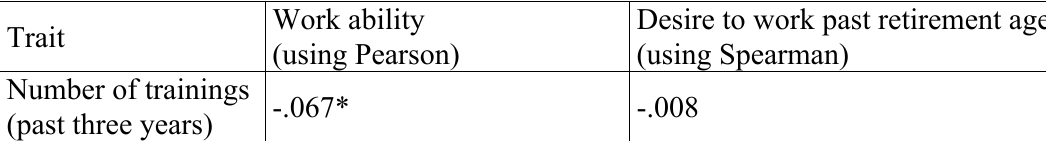
Table 3 . Correlation of actual trainings taken (within past three years) with work ability and with desire to work past retirement age (*…significant correlations at the p<.05